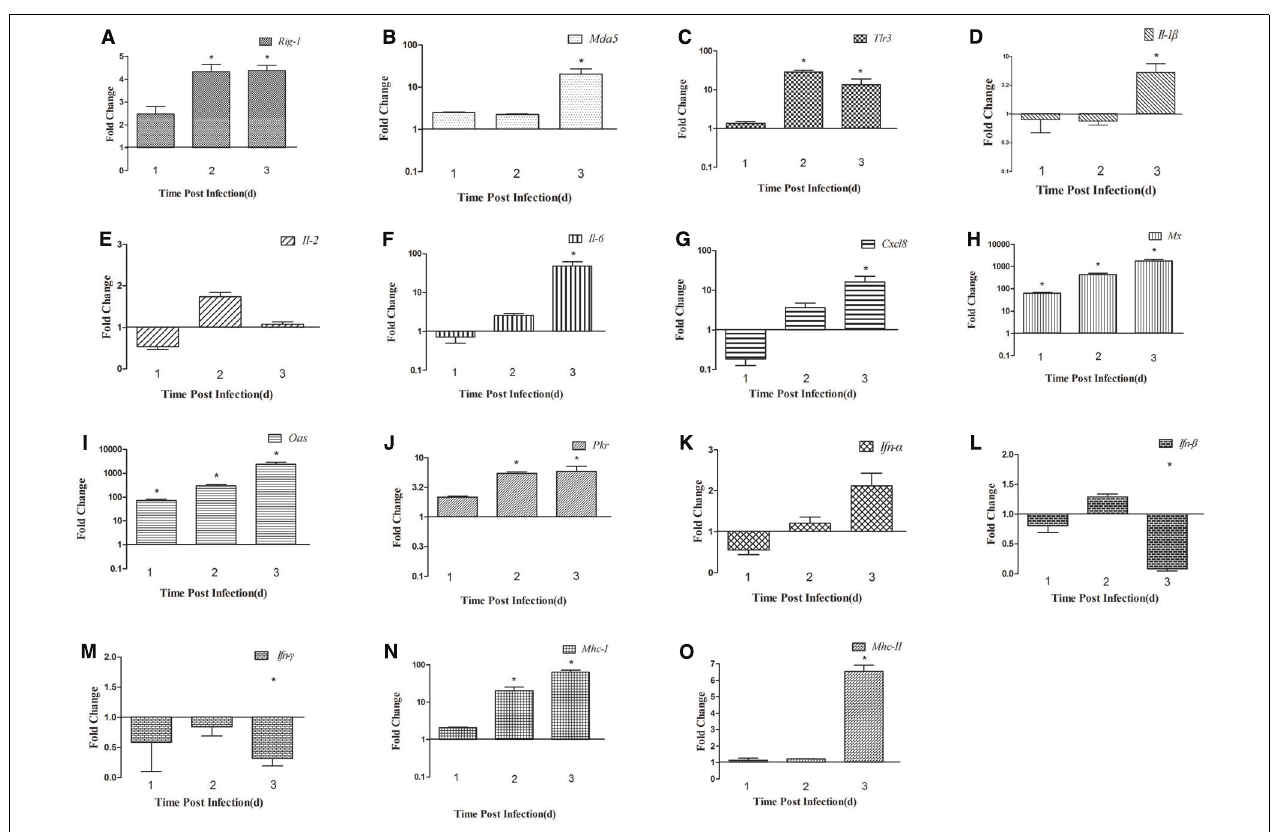
FIGURE 2 | Expression of immune-related genes in the brains of DTMUV-infected ducks. (A) Rig-1 , (B) Mda5 , (C) Tlr3 , (D) Il-1 b , (E) Il-2 , (F) Il-6 , (G) Cxcl8 , (H) Mx , (I) Oas , (J) Pkr , (K) Ifn- a , (L) Ifn- b , (M) Ifn- g , (N) Mhc-I , and (O) Mhc-II . The Y axis represents the fold change in target gene